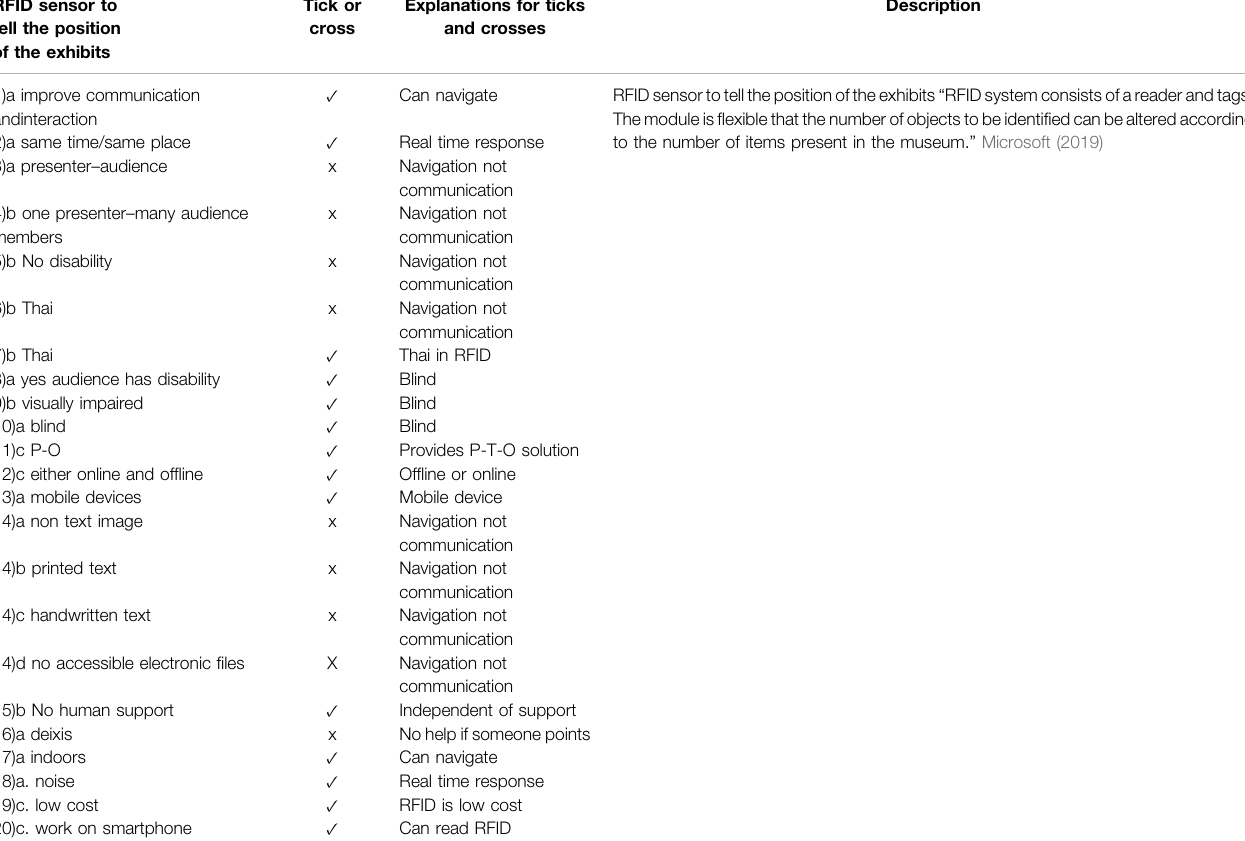
Tick or Explanations for ticks cross and crosses